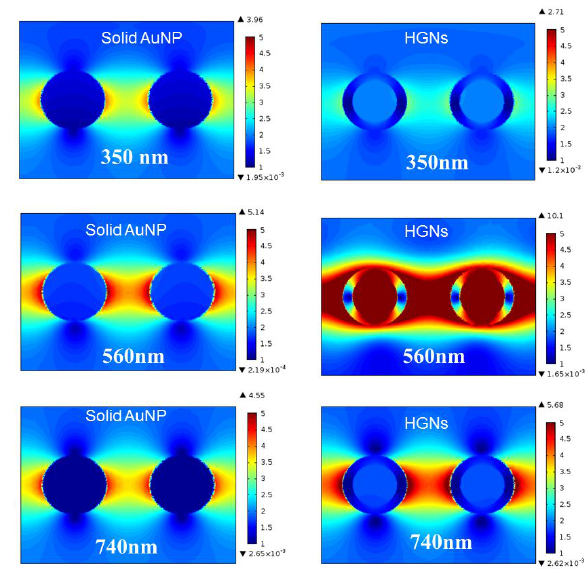
Fig. 7. The electrical field distribution of both solid AuNP and HGNs under light illumination of 350, 560, and 740 nm. The solid AuNP has a diameter of 30 nm, and the HGN has a diameter and aspect ratio of 30 nm and 70%,